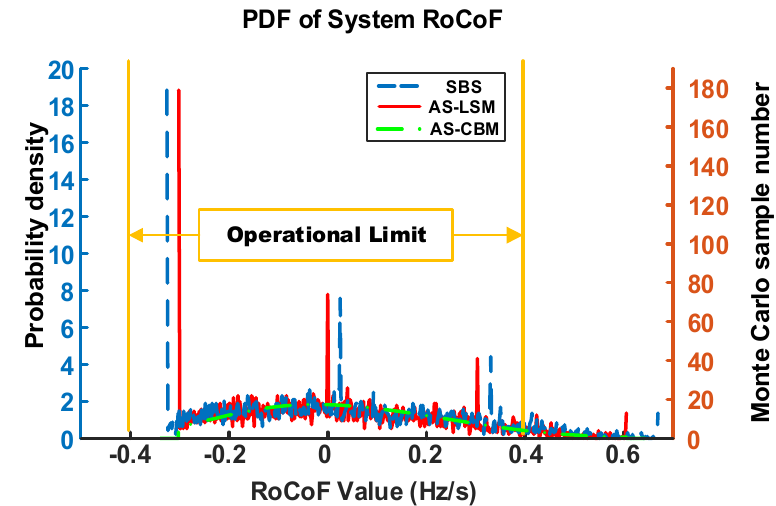
Figure 6. PDF of system RoCoF by SBS, AS-LSM, and AS-CBM.